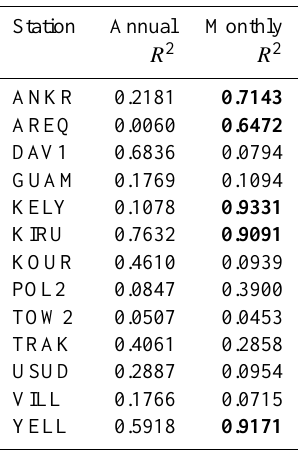
Table 6. Testing whether RMSEEs from individual latitudinal short session regression models are identical to RMSDs formed using 24h solutions as the truth (1mm threshold is used). The identical solutions are shown with bold